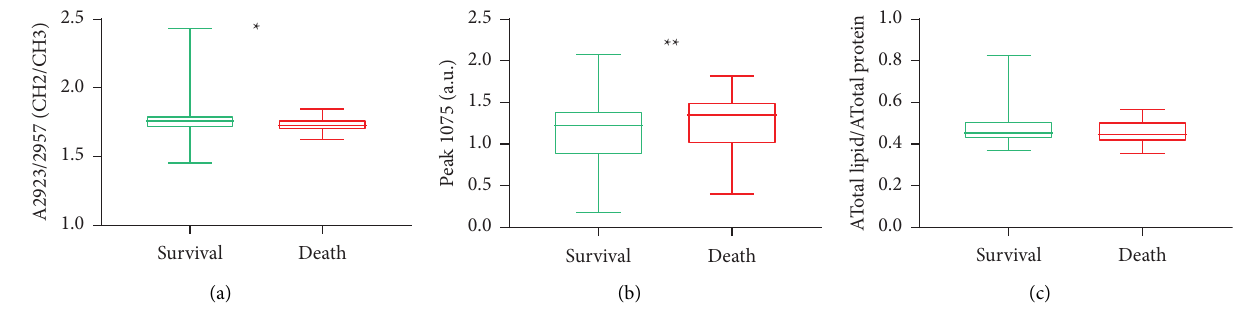
Figure 2: Lipids analysis using ATR-FTIR spectra (median and RIQ) on hospitalized patients with severe COVID-19 who survived or